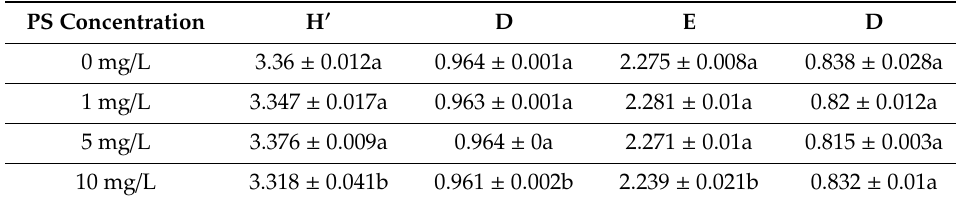
Table2. Themetabolicfunctionaldiversityindicesindicatingthatsignificantdi ff erencesonlyoccurredin the 10 mg / L NP group compared to the control in terms of H’, D, E and D . H’ stands for Shannon–Wiener diversity index, D stands for Simpson diversity index, E stands for Shannon evenness index, D stands for McIntosh index. Data in the table are the mean ± variance, n = 3. Using Duncan’s multiple range test of diversity indices separately, di ff erent letters (a / b) in each index represent the significant di ff erence at p < 0.05.